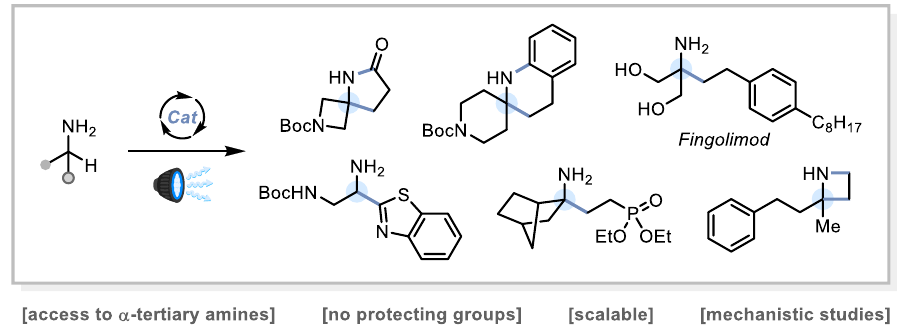
Figure 20. Photocatalytic α-C–H functionalization of primary aliphatic amines. 4.13. New Orthogonal Decoration of 4-Amino-pyrido[2,3-d]pyrimidin-7(8H)-ones (P13)